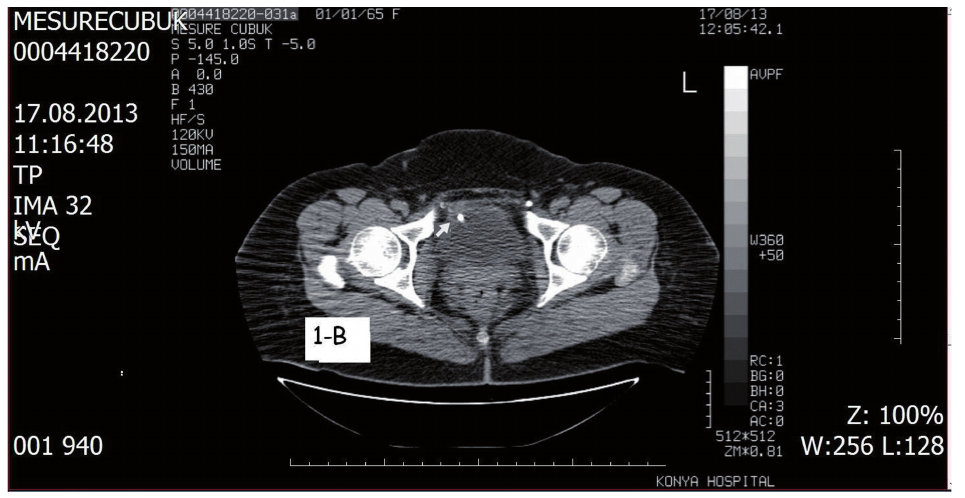
Figure 1b - Tomography (CT) image of endotacker inside the bladder.